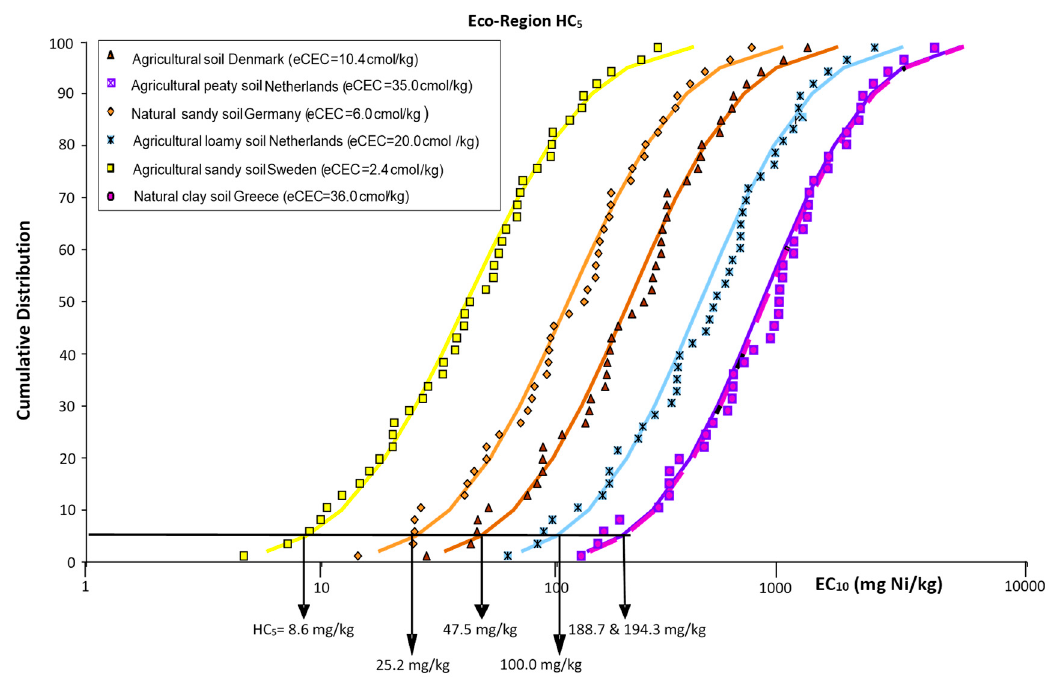
Figure 3. Species sensitivity distributions (SSDs) of soil organisms mean EC10 values ( n = 42) for soils with different effective cation exchange capacities (eCEC). The 5th percentile of the hazard concentration (HC5) was calculated for each SSD yielding a range of HC5s from 8.6 to 194.3 mg Ni/kg. The “Agricultural peaty soil Netherlands” overlaps with the “Natural clay soil Greece” in the graph, with similar eCEC values of 35.0 cmol/kg and 36.0 cmol/kg, respectively.